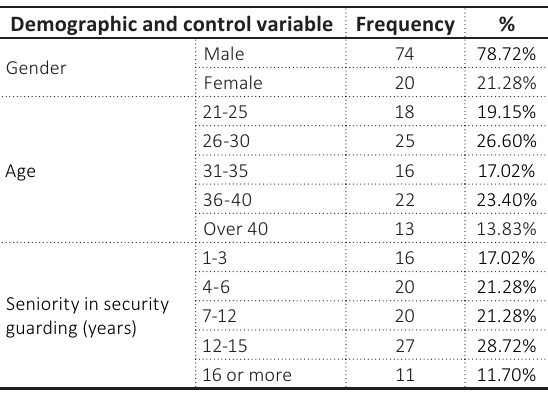
Table 1. Respondents’